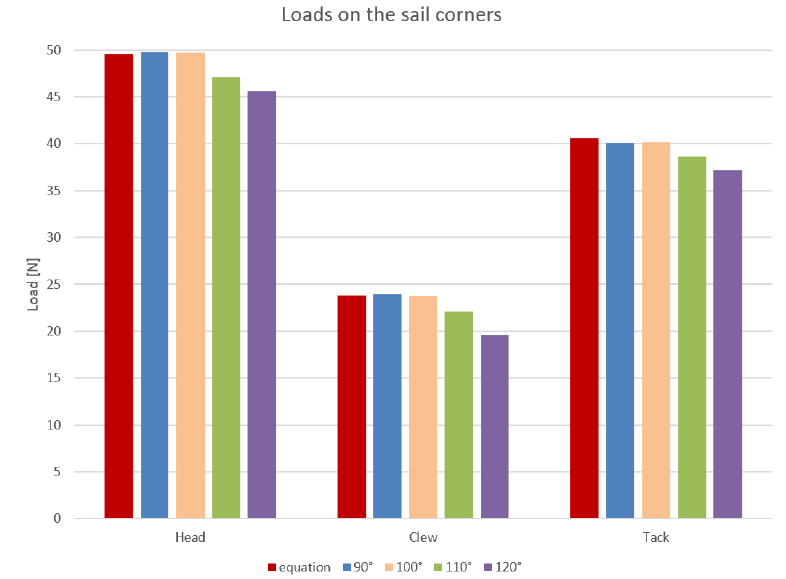
Figure 20. Plots of the loads on the sail corners calculated by the CFD simulations and by Equa-